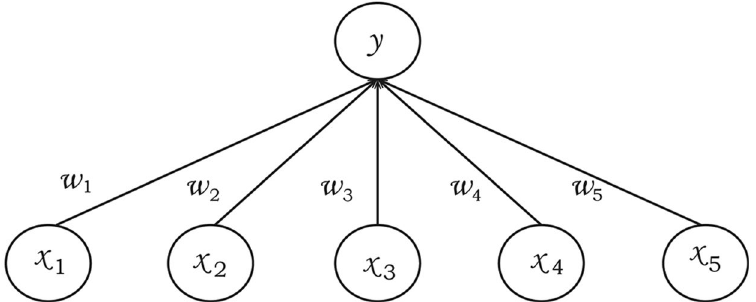
Figure 9. The schematic representation of the ensemble averaging, which can be viewed as an interpolation (ESP) is also calculated for subsequent analysis. The adopted DFT/TDDFT methods have been carefully cali- brated with known experimental evidence in our previous work 62 , and can be used for thousands to millions energy and gradient calculations. Dynamics treatment with more accurate electronic-structure and advanced dynamical methods at all atoms level should represent the great challenge for future theoretical chemistry. All electronic structure calculations were performed with Gaussian 09 package 76 . The data sets and some scripts can be obtained upon request or downloaded from https://github.com/dulikai/bidiu. The Clustering Algorithms. The dynamics of complex systems typically involves various meta-stable inter- mediates. It is necessary to decompose conformation space into a set of kinetically meta-stable states. Although the meta-stable state is not a static structure, which can be represented as an ensemble of structures with similar geometric features. This can be achieved by various clustering algorithms, such as K-means clustering, mean shift, hierarchical clustering, artificial neural network and etc. Here, the K-means, as a simple and robust algorithm, is used to classify the conformation space into a set of discrete states or clusters, which should be corresponding to basins of attraction of local minima on the PES. The K-means clustering algorithm aims to partition n observations into k clusters, in which each observation belongs to the cluster with the nearest mean, serving as a prototype of the cluster. The most critical parameter in the K-means clustering is the number ( k ) of the clusters or the centroids. Thus, we have tested many cluster num- bers (i.e. k = 4~400). And the selection of cluster number should be an iterative procedure. The geometric RMSD value of each cluster is a very suitable criteria (Table S2). The subsequent analysis also verified that 12 clusters are sufficient and efficient. The molecular internal coordinates are used as molecular descriptors for clustering, especially, a few critical dihedral angles 62, 77 are chosen to characterize the excited state motion of the SA molecule (Fig. 8). The protocol is implemented with scikit-learn module 78 in Python. The Prediction with Ensemble Models. The clustering algorithm ensures that similar conformations are grouped into the same meta-stable states or clusters, in a methodical and unbiased fashion. Thus, the dynamics process could be represented by only a limited number of meta-stable patterns. The conformations in the same cluster should have much similar properties (low bias) than among different clusters (high variance). And we can estimated the transition probabilities between meta-stable states by counting the number of transitions along the time series of the trajectories, and thus form a kinetic meta-stable states network, namely time series fusion (TSF) network. Based on the concept of ensemble averaging 79–81 , we suggest an interpolation scheme, namely Prediction with Ensemble Models (PEM) algorithm, to build a model and predict reliable molecular properties, such as charge population and excitation energy. In the machine learning realm, ensemble averaging is one of the simplest types of committee machines, which provides an ideal technique to combine multiple models or patterns to produce a desired output. Usually, an ensemble of models performs better than any individual model, because the various errors of the models can be averaged out 79 . In summary, ensemble averaging creates a group of networks, each with low bias and high variance, and combines them to a new network with low bias and low variance. It is thus a possible solution of the bias-variance dilemma 79, 81 . The theory of ensemble averaging relies on two properties of artificial neural networks: 1) In any network, the bias can be reduced at the cost of increased variance. 2) In a group of networks, the variance can be reduced at no cost to bias. In this work, a general version of ensemble averaging is defined as a weighted sum of finite number of clusters, with low bias and high variance (Fig. 9). If the molecule descriptors ( X ) are specified, the estimated result V can be defined as In the above equation, T ij is the property of one element ( j ) in each cluster ( i ), and the distinct clusters are generated by the K-means algorithm from the time series of trajectories. And M is the number of clusters, n is the number of possible elements in each cluster, and ω is a set of weights. The same sets of geometric based molecular